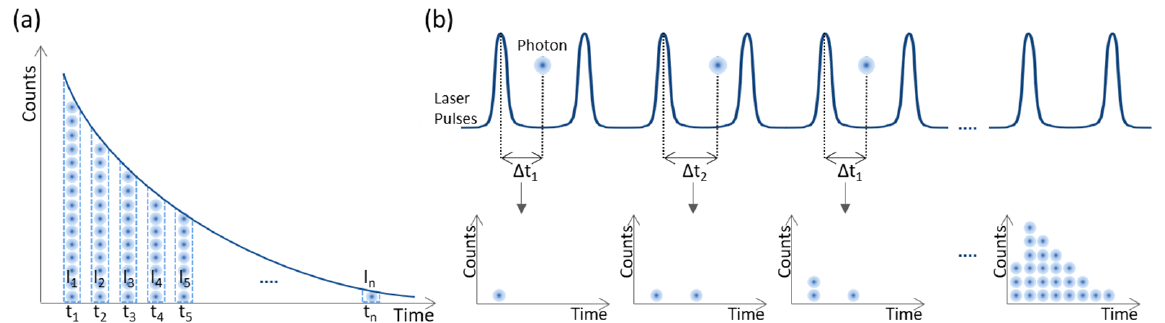
Figure 3. Schematic representation of time-gated ( a ) and time-correlated single photon counting ( b ) principles of operation.